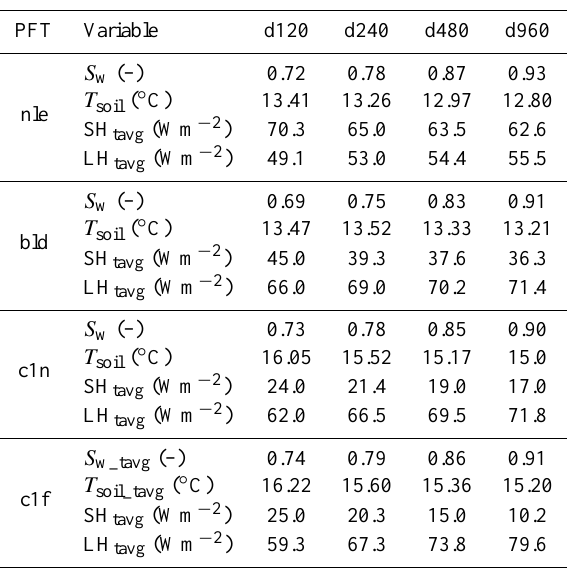
Table 3. Mean sub-catchment relative soil moisture ( S w ), soil tem- perature T soil , sensible SH tavg and latent fluxes LH tavg for grid columns with land-use classes nle (needleleaf evergreen tree), bld (broadleaf deciduous tree), c1n (crops with seasonal LAI), and c1f (crops with fixed